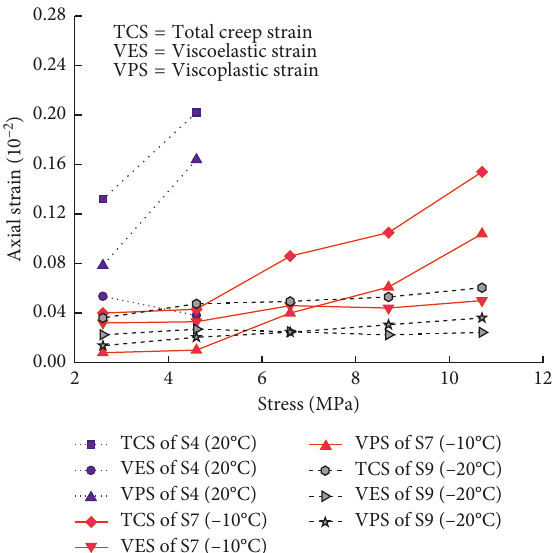
Figure 8: Total creep, viscoelastic strain, and viscoplastic strain versus stress.